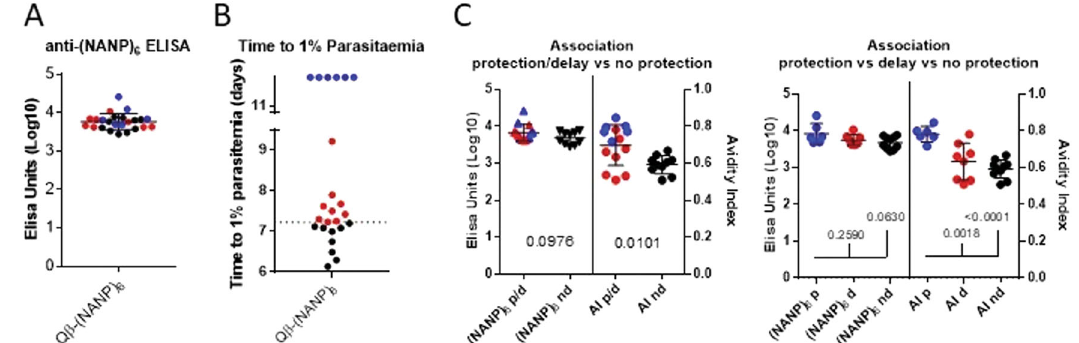
Fig. 5 Avidity index as a correlate of protection in Q β -(NANP) 6 -vaccinated mice. BALB/c mice ( n = 24) were vaccinated with Q β -(NANP) 6 by intramuscular injection, using 1 µg per dose, two shots, a 3-week prime-boost interval, and Matrix-M ™ adjuvant. A Serum was collected from mice 2 weeks post-boost and standard curve ELISA performed against (NANP) 6 . B Mice were challenged intravenously with 1000 PfCSP transgenic P. berghei sporozoites 3 weeks post-boost. Daily thin blood smears were used to determine the time to reach 1% blood-stage parasitaemia by linear regression. Mice with sterile protection are coloured blue, and those with a delay in time to reach 1% blood-stage parasitaemia coloured red, where “ delay ” is de fi ned as time-to-1% greater than the mean of naïve challenged mice plus two standard deviations. C Associations with protection were obtained by categorising mice into two or three groups following challenge: protected or delayed (p/d) vs. no delay (nd), or protection (p) vs. delay (d) vs. no delay (nd). Numbers represent p values t tests (comparing two groups) or ANOVA with Bonferroni ’ s multiple comparisons test (comparing three groups). Means are shown ±